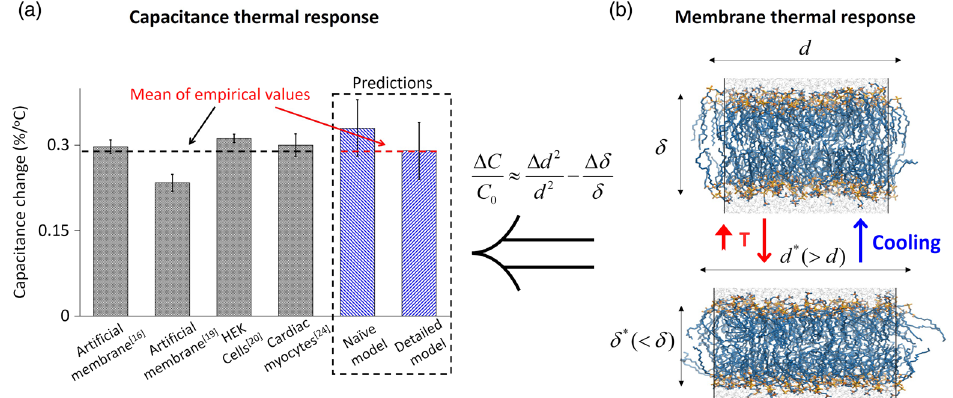
FIG. 1. Universal membrane capacitance thermal response rate, explained by membrane dimensional changes. (a) Membrane capacitance change rates measured in different studies and preparations (gray bars) versus predictions from the thermal dimensional response of POPC membrane bilayers (naive plate capacitor model), and from a detailed biophysical model accounting for spatial charge distribution. (b) Schematized membrane thinning and area expansion under temperature elevation. This observed process [30 – 33] is thought to result from an increase in the phospholipid molecules ’ fatty acid chains trans-gauche rotational isomerization, which shortens the tails ’ effective length and increases the area per phospholipid molecule. Biophysically, these two phenomena contribute to a predictable increase in both the membrane hydrophobic core ’ s and total capacitance. Error bars for the direct capacitance measurements are (cid:1) s : e : m, and for the model predictions are (cid:1) chi-squares distribution-related uncertainty